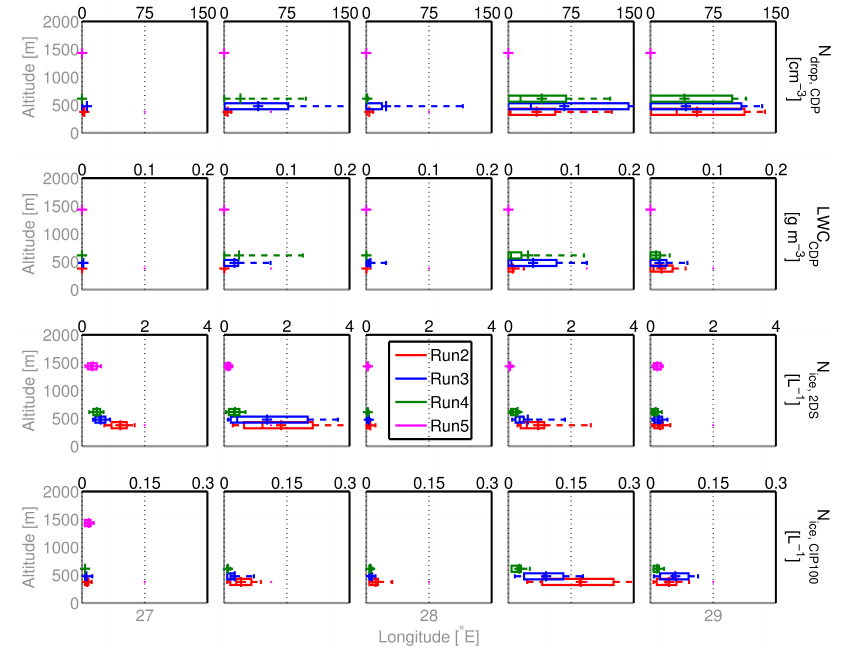
Figure 7. Percentile plots of CDP droplet number concentration (first row), CDP liquid water content (second row), 2DS ice number concen- tration (third row) and CIP100 ice number concentration (fourth row) measured over the sea ice. Each column represents a different longitude bin, moving from west (left) to east (right). Data are plotted against altitude (grey axis) and are coloured differently dependent on the SLR at which the data were measured, as indicated in the legend. Data correspond to the scale on the top x axis of each